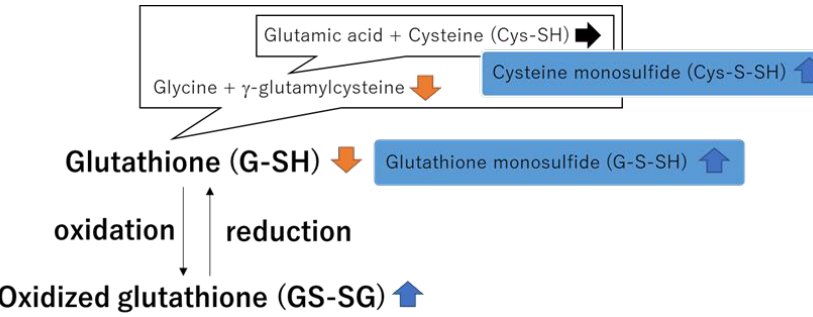
Figure 9. Changes in G-SH-, Cys-SH-, and RSS-related metabolites after radon inhalation. The figure shows an illustration of the reduction and oxidization of G-SH. G-SH is synthesized from γ -glutamylcysteine and glycine. γ -glutamylcysteine is synthesized from glutamic acid and Cys-SH. The sulfur ion possibly chemically binds with G-SH or Cys-SH. The changes in G-SH- and Cys-SH-related metabolites are indicated by arrows. indicates an increase, indicates a decrease, and indicates no change in radon exposure groups compared with the control.